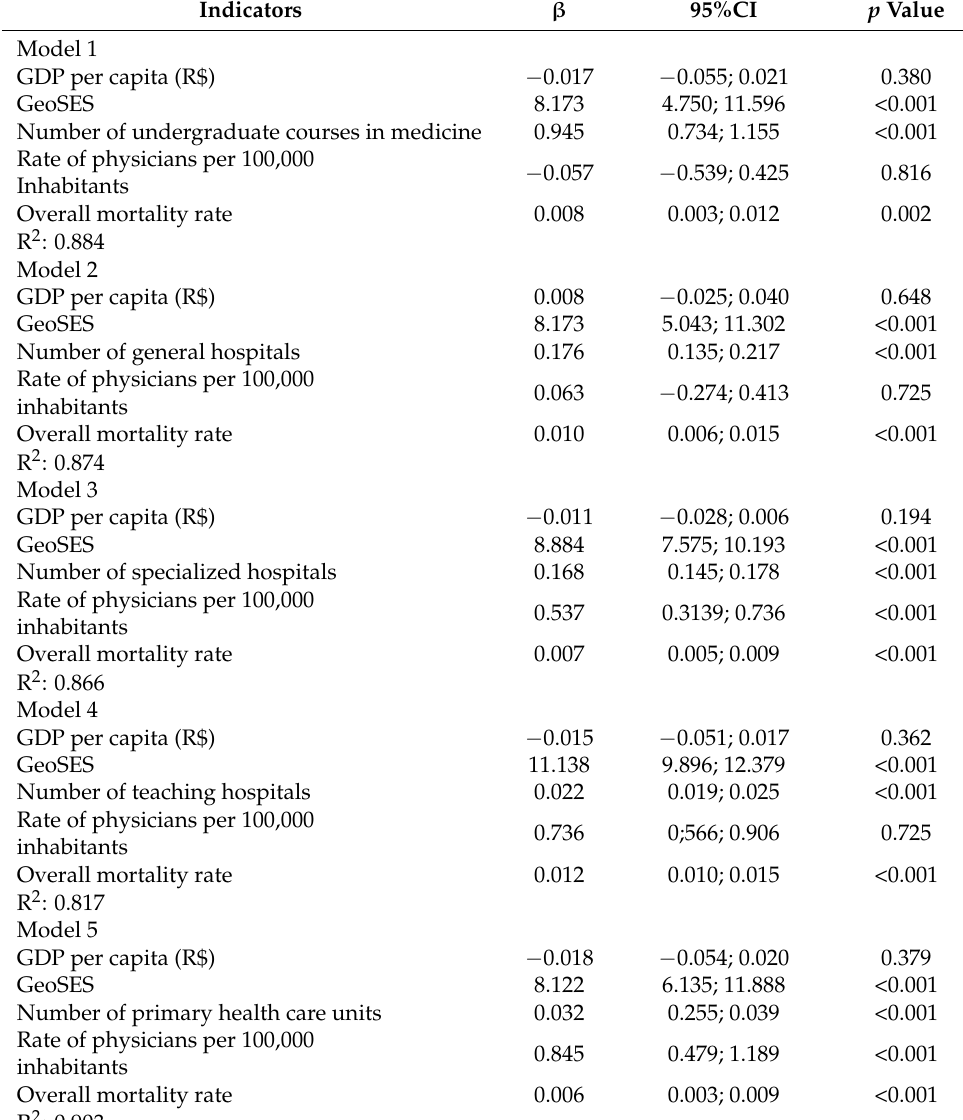
Table 6. Factors associated with the number of MRPs offered. North region, Brazil,